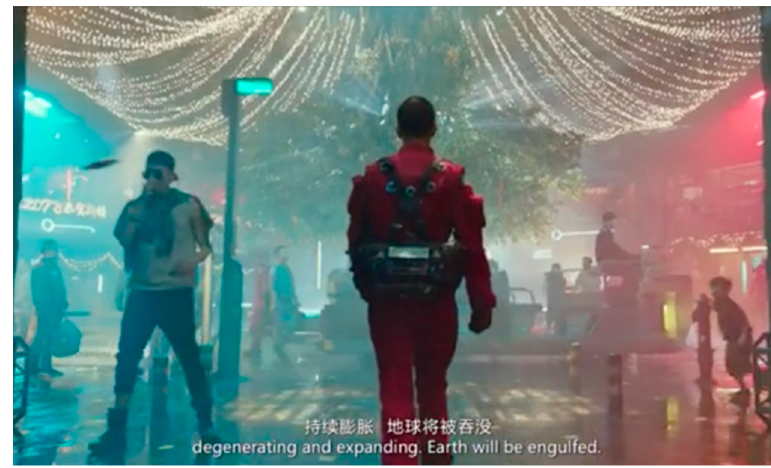
Figure 4. Liu Qi walks out of the underground city.